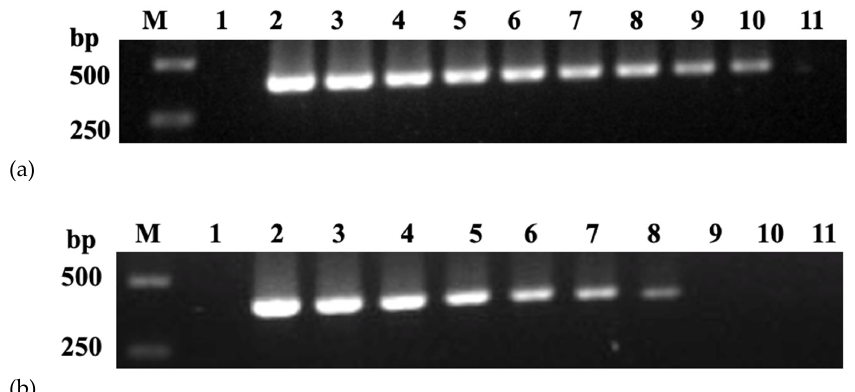
Figure 3. The sensitivity of nanoPCR (a) and conventional PCR (b): ( a ) Lane M, DL 2,000 Marker; Lane 1, negative control; Lanes 2-11, 4.68×10 10 , 4.68×10 9 , 4.68×10 8 , 4.68×10 7 , 4.68×10 6 , 4.68×10 5 , 4.68×10 4 , 4.68×10 3 , 4.68×10 2 , and 4.68×10 1 copies/ μ L; ( b ) Lane M, DL 2,000 Marker; Lane 1, negative